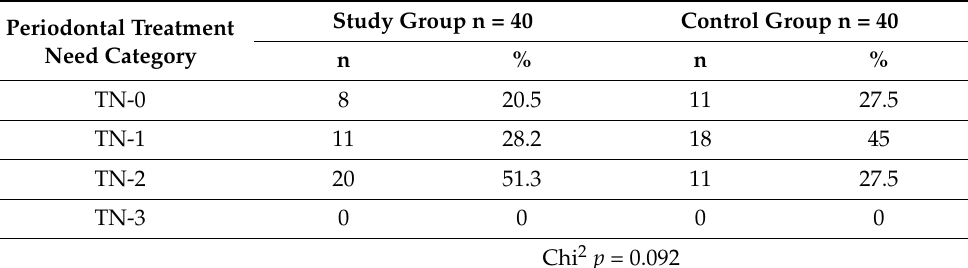
Table 4. An analysis of treatment needs (TN) based on the CPITN index in the study and control